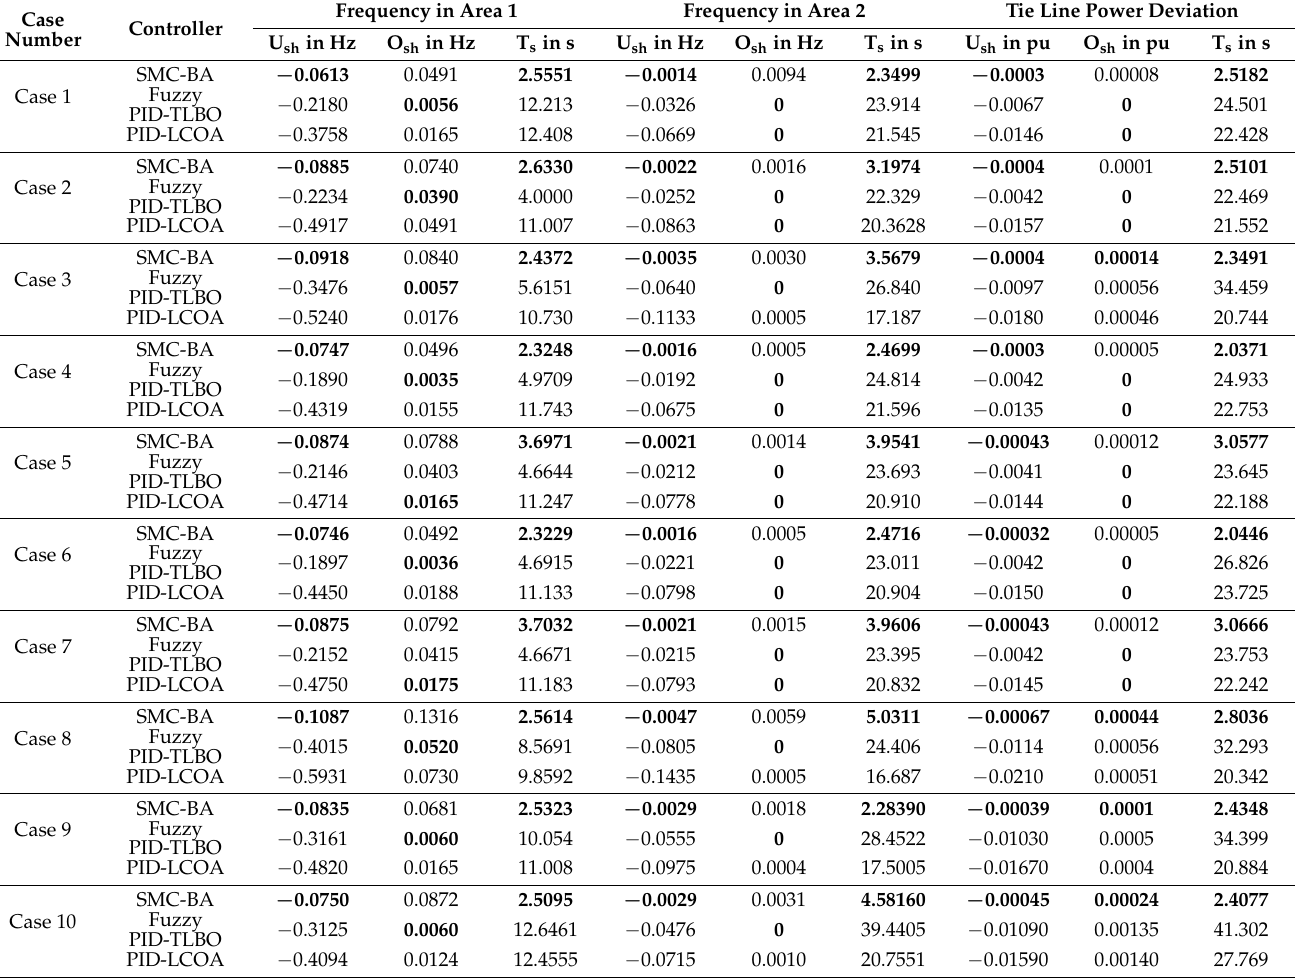
Table 7. Dynamic response of the system under different parametric uncertainties scenarios with different